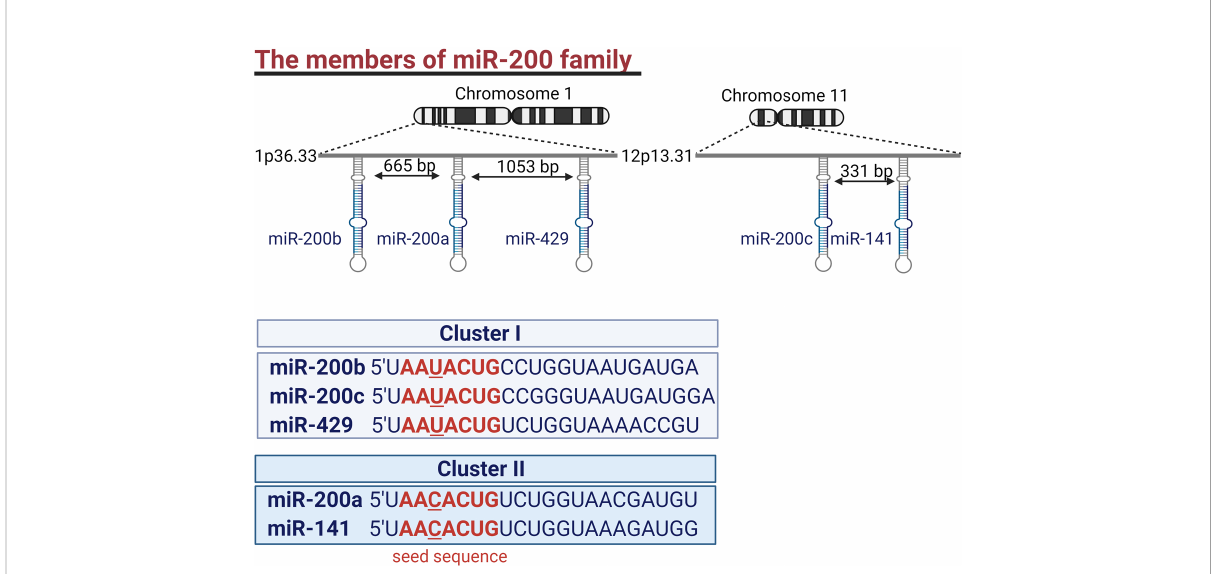
FIGURE 1 The members of the miR-200 family. Genes encoding the miR-200 family form two clusters. One encoding miR-200b, miR-200a, and miR- 429 is located in chromosome 1 while miR-200c and miR-141 are encoded by genes located in chromosome 11. Members of the miR-200 family are characterized by AA(U/C)ACUG seed